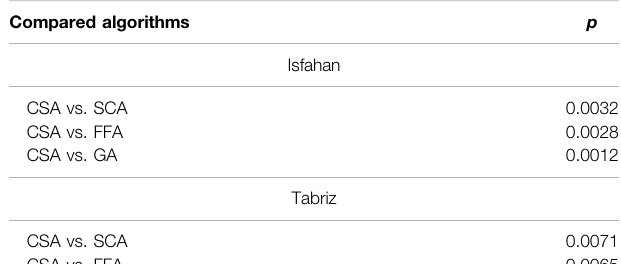
TABLE 5 | The obtained results from the Wilcoxon test over different